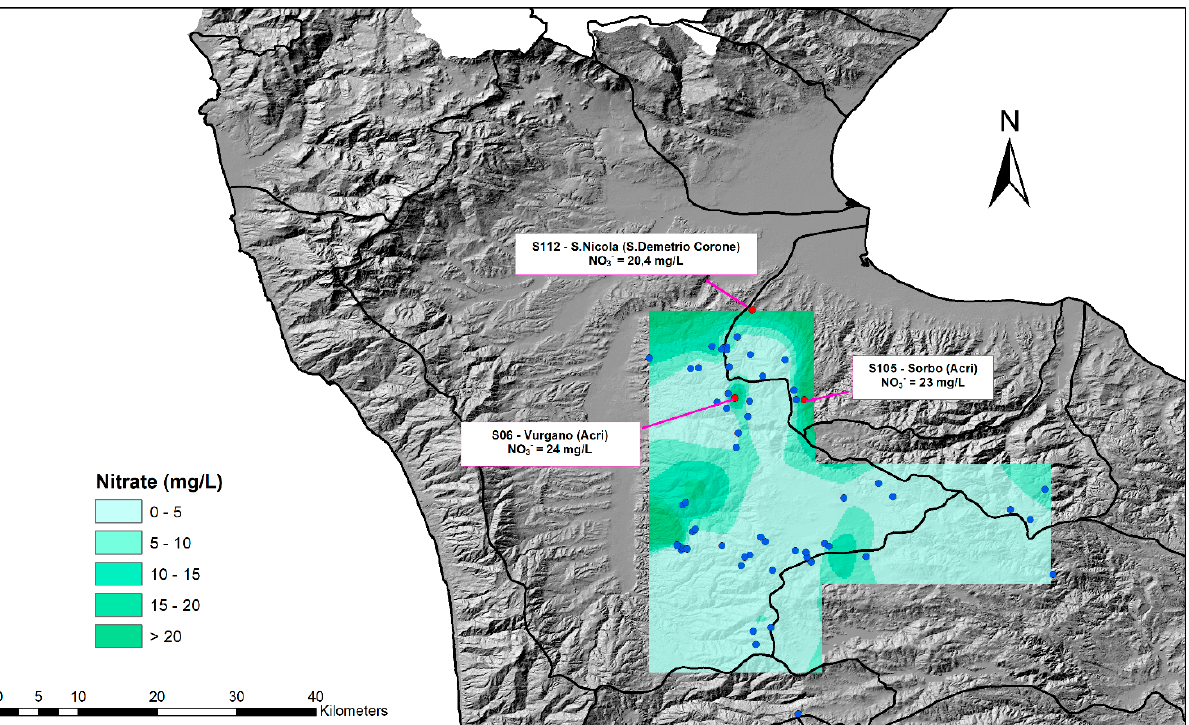
Figure 6. Spatial distribution of nitrates in the study area.